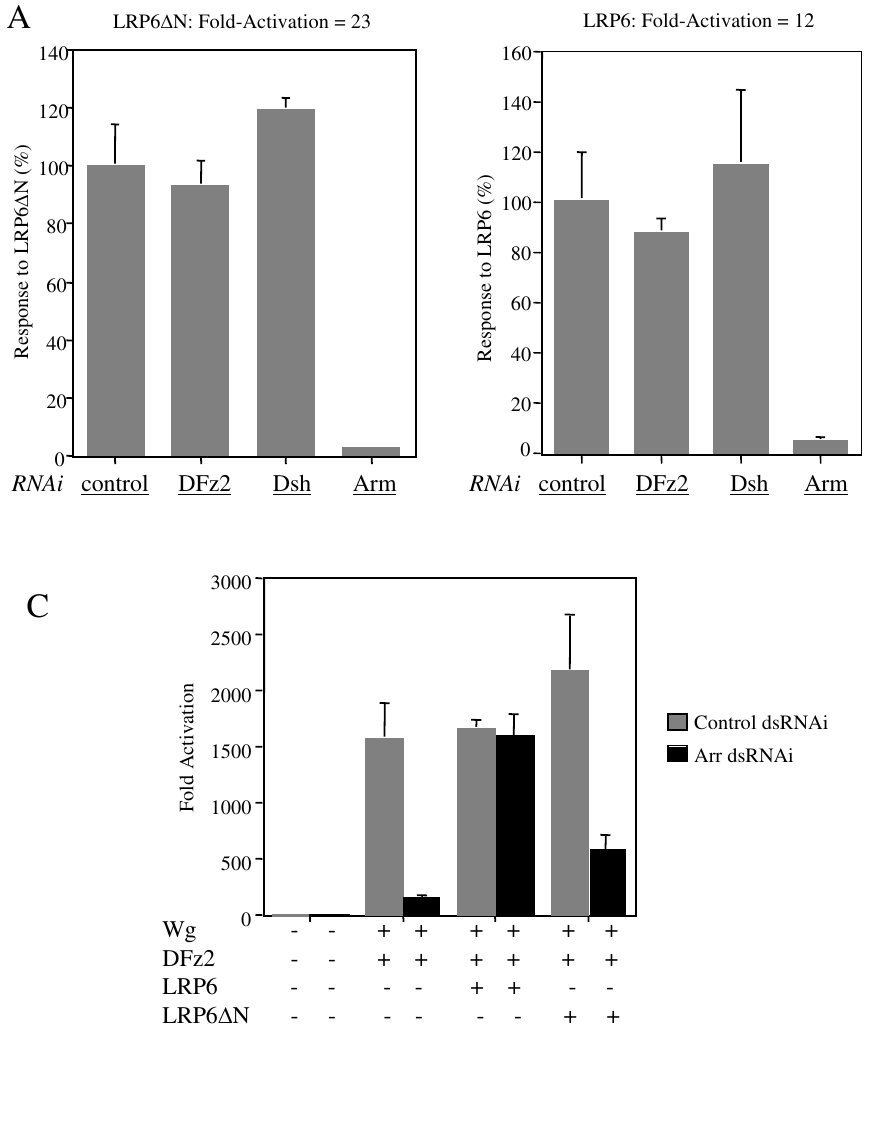
LRP ∆ N activate the pathway independent of DFz2 and Dsh and N-terminus of LRP is required for the synergis- tic activity of Wg and DFz2. S2 cells were treated with the following dsRNAs: control Aco (A-C), DFz2 (A, B), Dsh (A, B), Arm (A, B) and Arr (C). The next day cells were transfected with indicated expression plasmids. Fold activation values were measured relative to the levels of luciferase activity in cells transfected with empty vectors and normalized by Renilla luciferase activities. The level of fold activation was set to 100% for cells treated with Aco dsRNA and the actual values are indicated above the figures (A, B). All experiments were done in triplicate; error bars represent standard